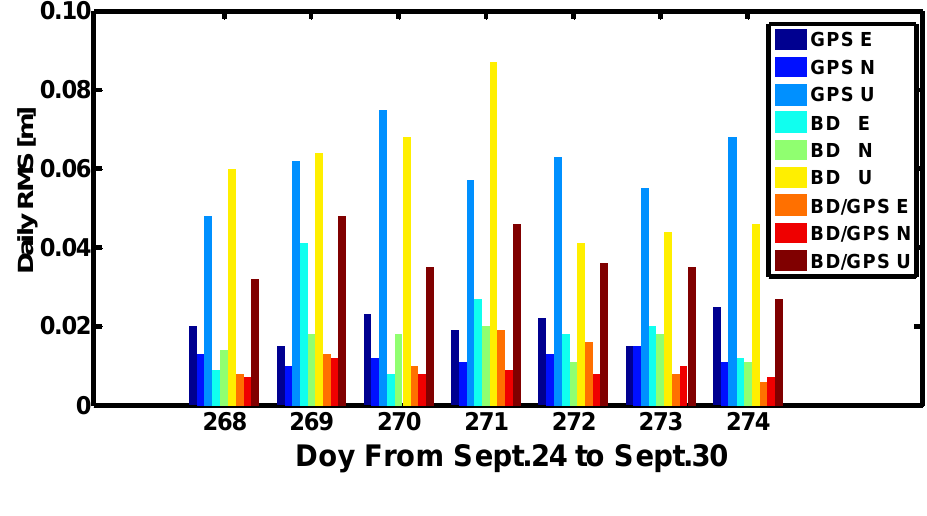
Figure 10. Daily RMS values of BeiDou, GPS, and BeiDou/GPS kinematic PPP solutions of CHDU against the “ground truth” in the East, North and Up components from September 24 to September 30 in 2012 (Day of year is from 268 to